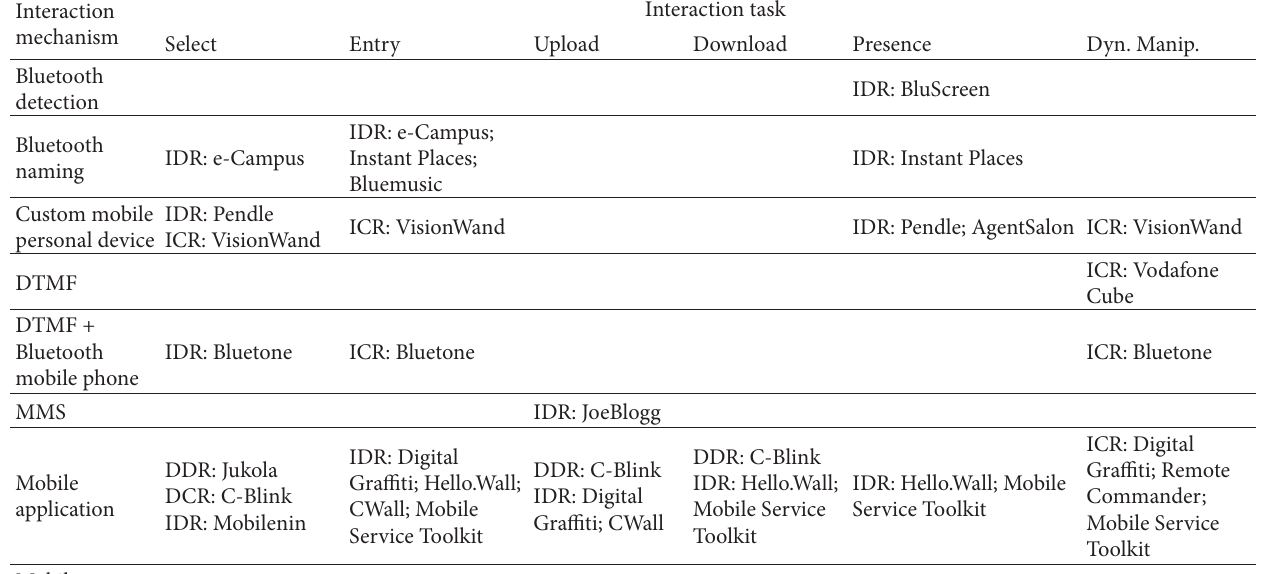
Table 3: Mapping between interaction tasks and interaction mechanisms based on personal mobile devices. Interaction